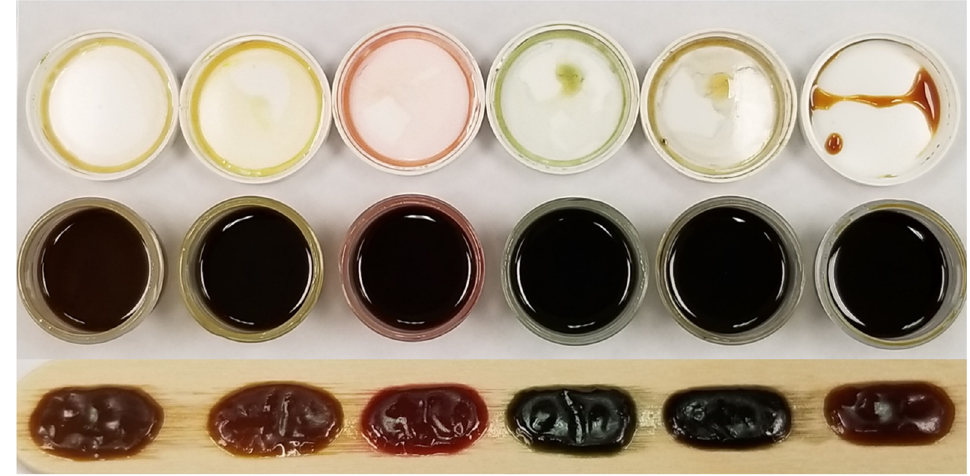
Figure 8. Lignin resins pigmented (left to right) with white, yellow, red, blue, black, and none